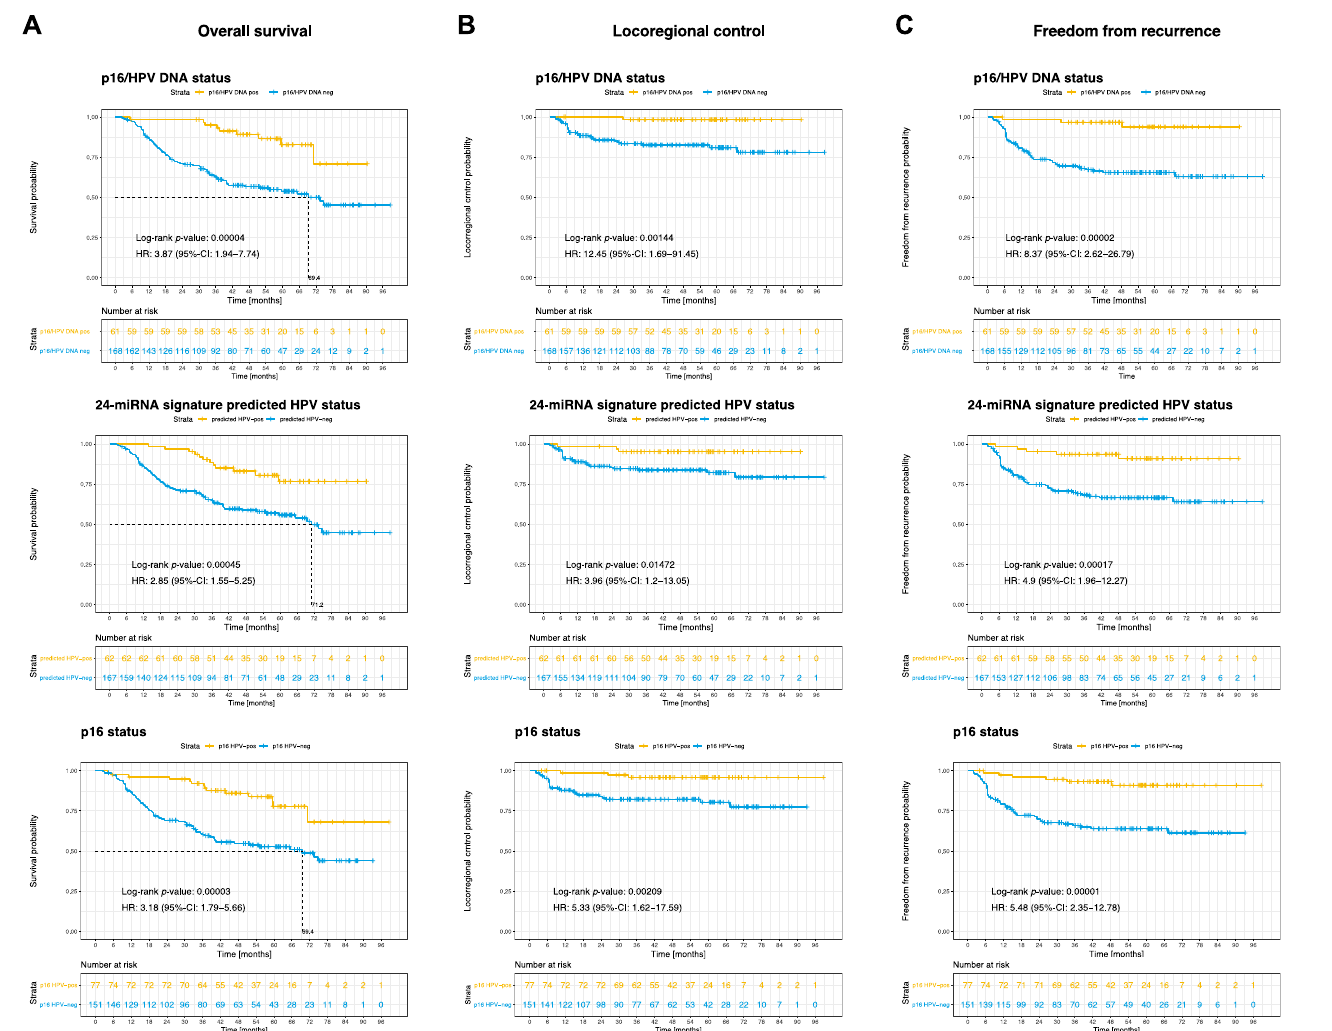
Figure 2. Prognostic value of the 24-miRNA signature and HPV-status. Kaplan-Meier curves for the endpoints ( A ) overall survival, ( B ) locoregional control and ( C ) freedom from recurrence stratified according to p16/HPV DNA status (top), 24-miRNA signature predicted HPV-status (middle), and p16 status (bottom). p -values are derived by log-rank test. Hazard ratios (HR) with 95% confidence intervals (CI) are given.